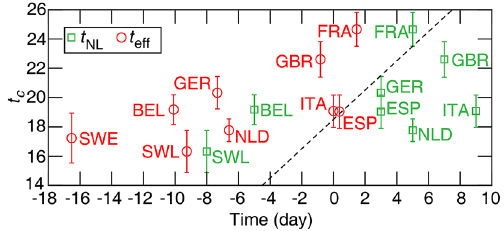
Figure 3. The time of the peak in daily deaths t c versus the official national lock-down date t NL and the effective social distancing date t eff . The correlation is weak with r 2 = 0.45 ( p = 0.06 ) for t eff , and r 2 = 0.12 ( p = 0.37 ) for t NL . Neither correlations are statistically significant. Dashed line: time (identity line) with a delay of 18.5 days. Error bars indicate standard error (SE).